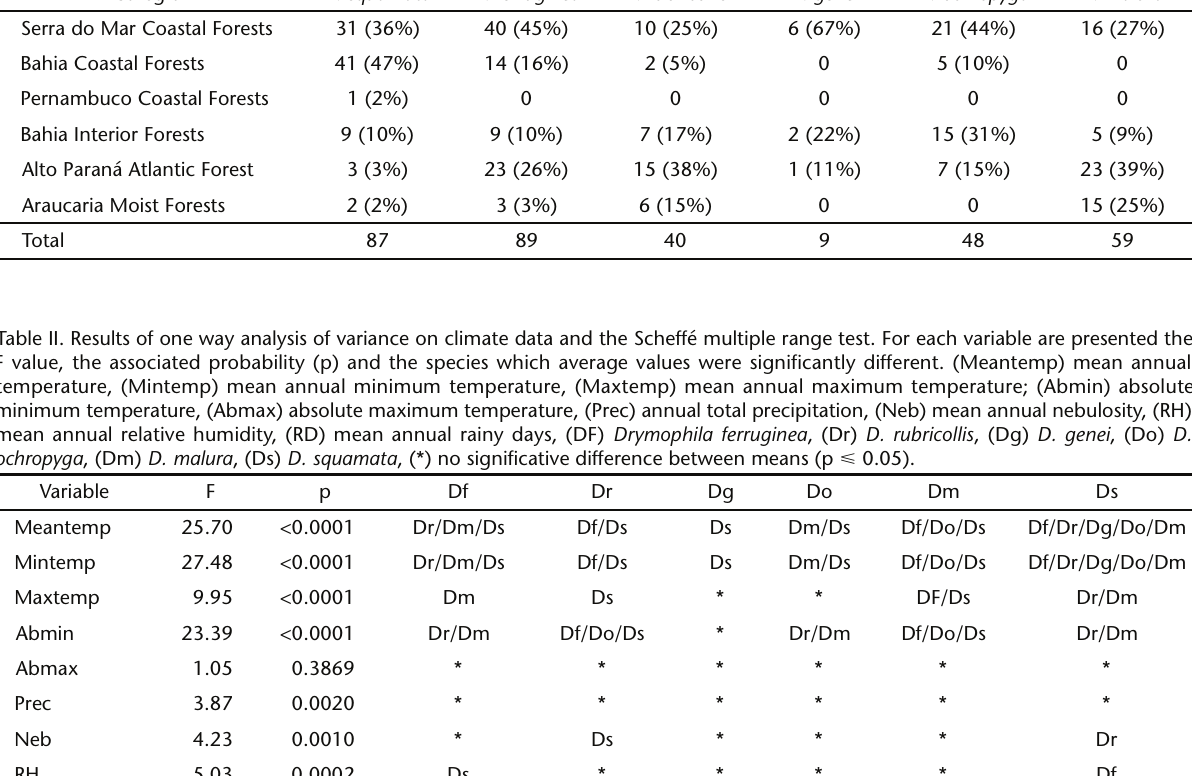
Table I. Number of localities and frequencies (in parentheses) of Drymophila in Atlantic Forest ecoregions. Ecoregion